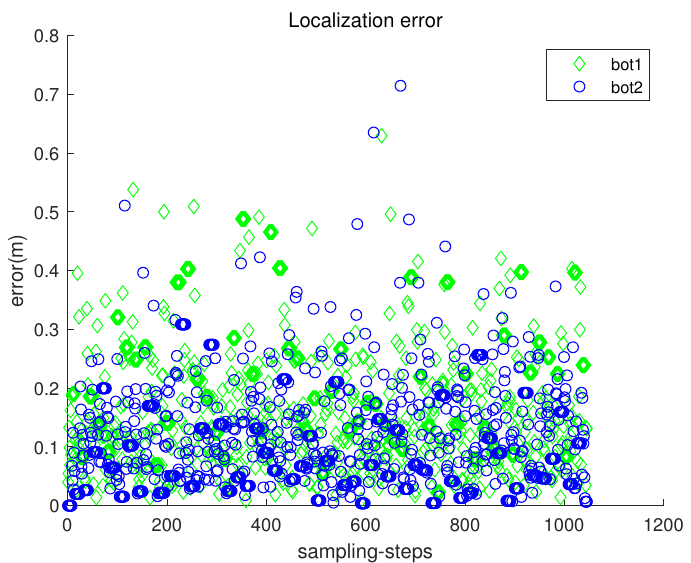
Figure 14. Scenario 3. The localization error (cid:107) r i ( k ) − ˆ r i ( k ) (cid:107) with respect to sampling-stamp k . The localization error in Scenario 3 is comparable to that in Scenario 2 (Figure 11), which verifies the robustness of the proposed location